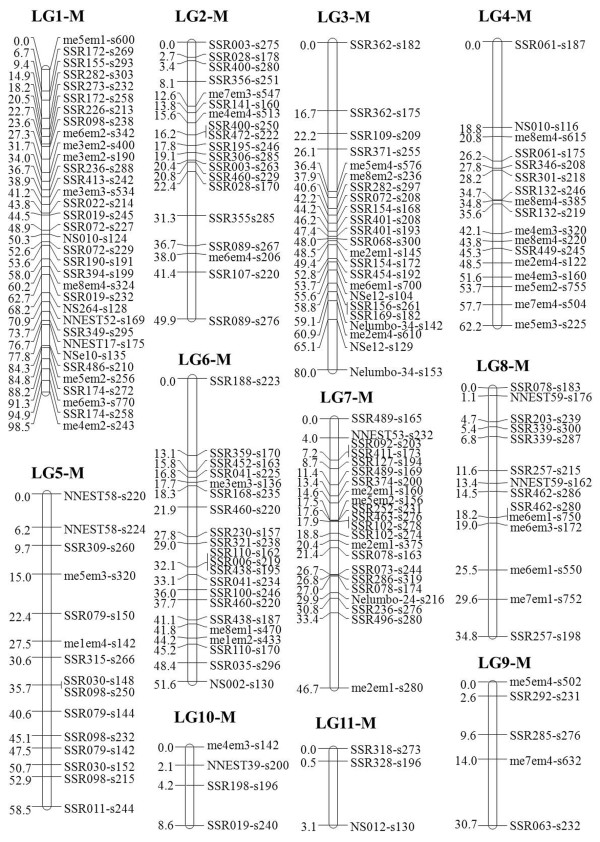
Genetic linkage map of American lotus (Nelumbo lutea) constructed with SSR and SRAP markers. Map distances in centi-Morgans (cM) and marker names are shown on the left and right sides of each linkage group (LG1-M to LG11-M), respectively. The marker nomenclature corresponds to the primer name followed by “s” (abbreviation of “size”) and the size of product (in base pair).